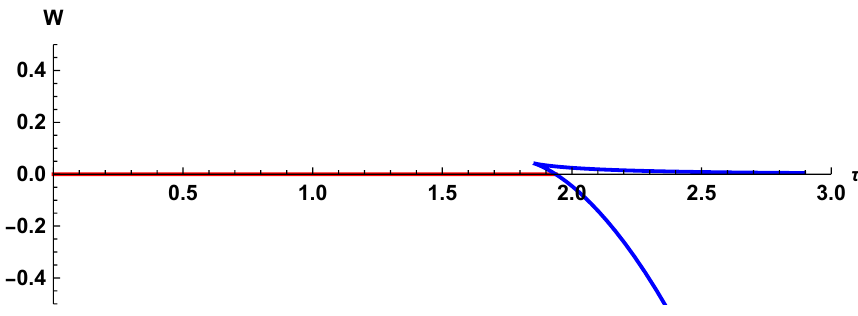
Figure 2 . The BPS free energy W vs. the BPS temperature τ as a function of the rotation parameter a , when a = b and ϕ 0 = 0 . The upper branch of the phase diagram is referred to as the “small” black hole branch and the lower branch is referred to as “large” black hole branch. The two branches meet at the cusp ( τ min , W max ) ≈ (1 . 852 , 0 . 0423) . The red line W = 0 in the range 0 < τ < τ HP represents the “thermal BPS” gas. The large black holes are thermodynamically preferred for τ > τ HP ≈ 1 . 937 .